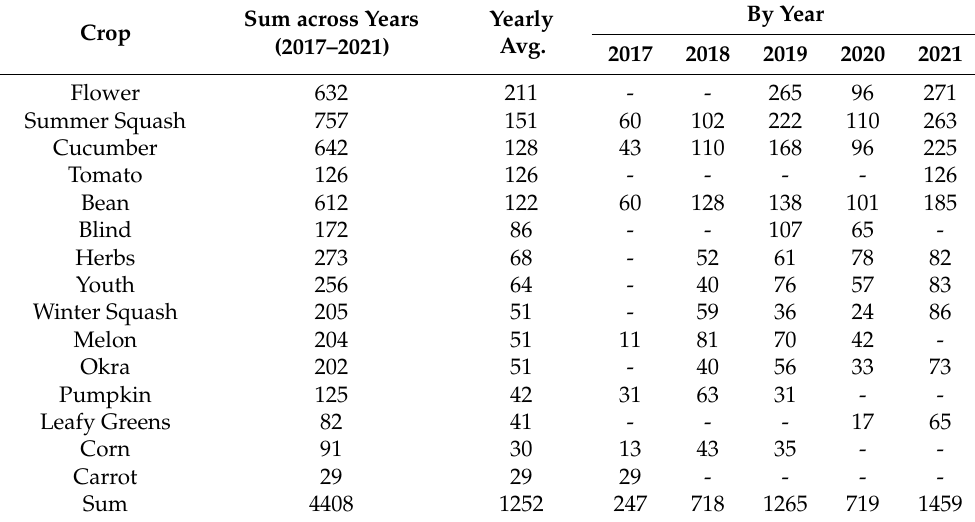
Table 1. Trials requested by crop by year from 2017 to 2021. Data are presented in descending order from the highest yearly average number requested. Crops that do not have data for a specific year were not offered as trials in that year.